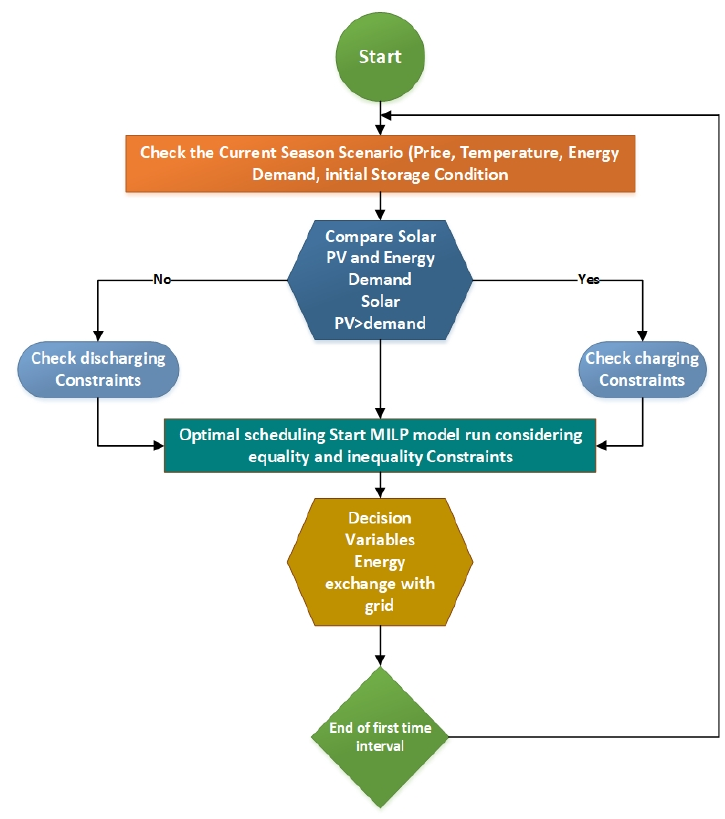
Figure 4. Proposed methodology of the given solution.